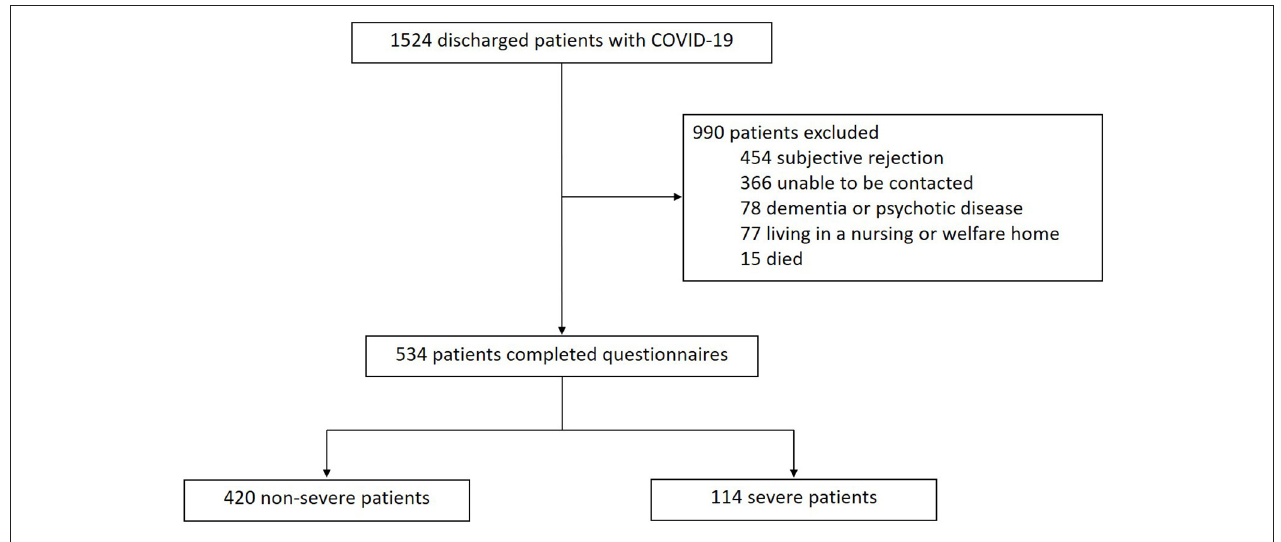
FIGURE 1 | Flow chart of hospital patients with